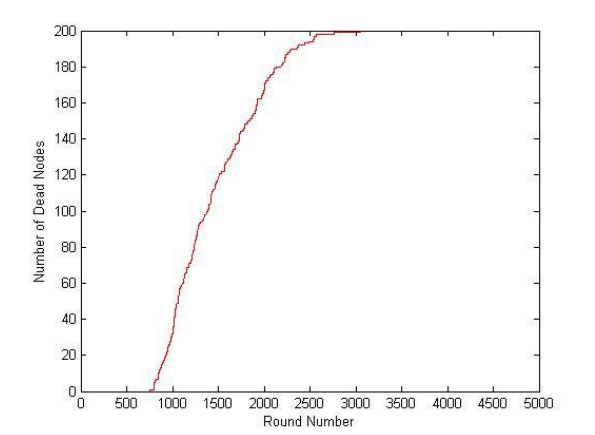
Figure 3. Number of Dead Nodes Vs Number of Round in SEP [19] Protocol